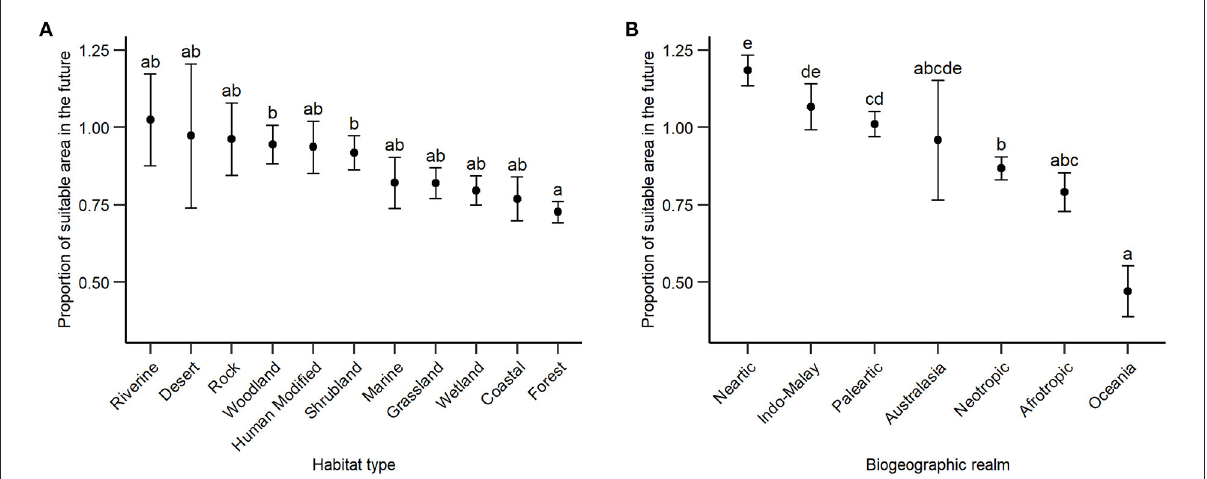
FIGURE4 Relationship between the average (black dots) proportion of birds’ suitable area and (A) habitat type, and (B) biogeographic realm. Values below 1 in y -axis represent suitable area loss. Different letters above the standard error of the mean indicate significant difference between two or more